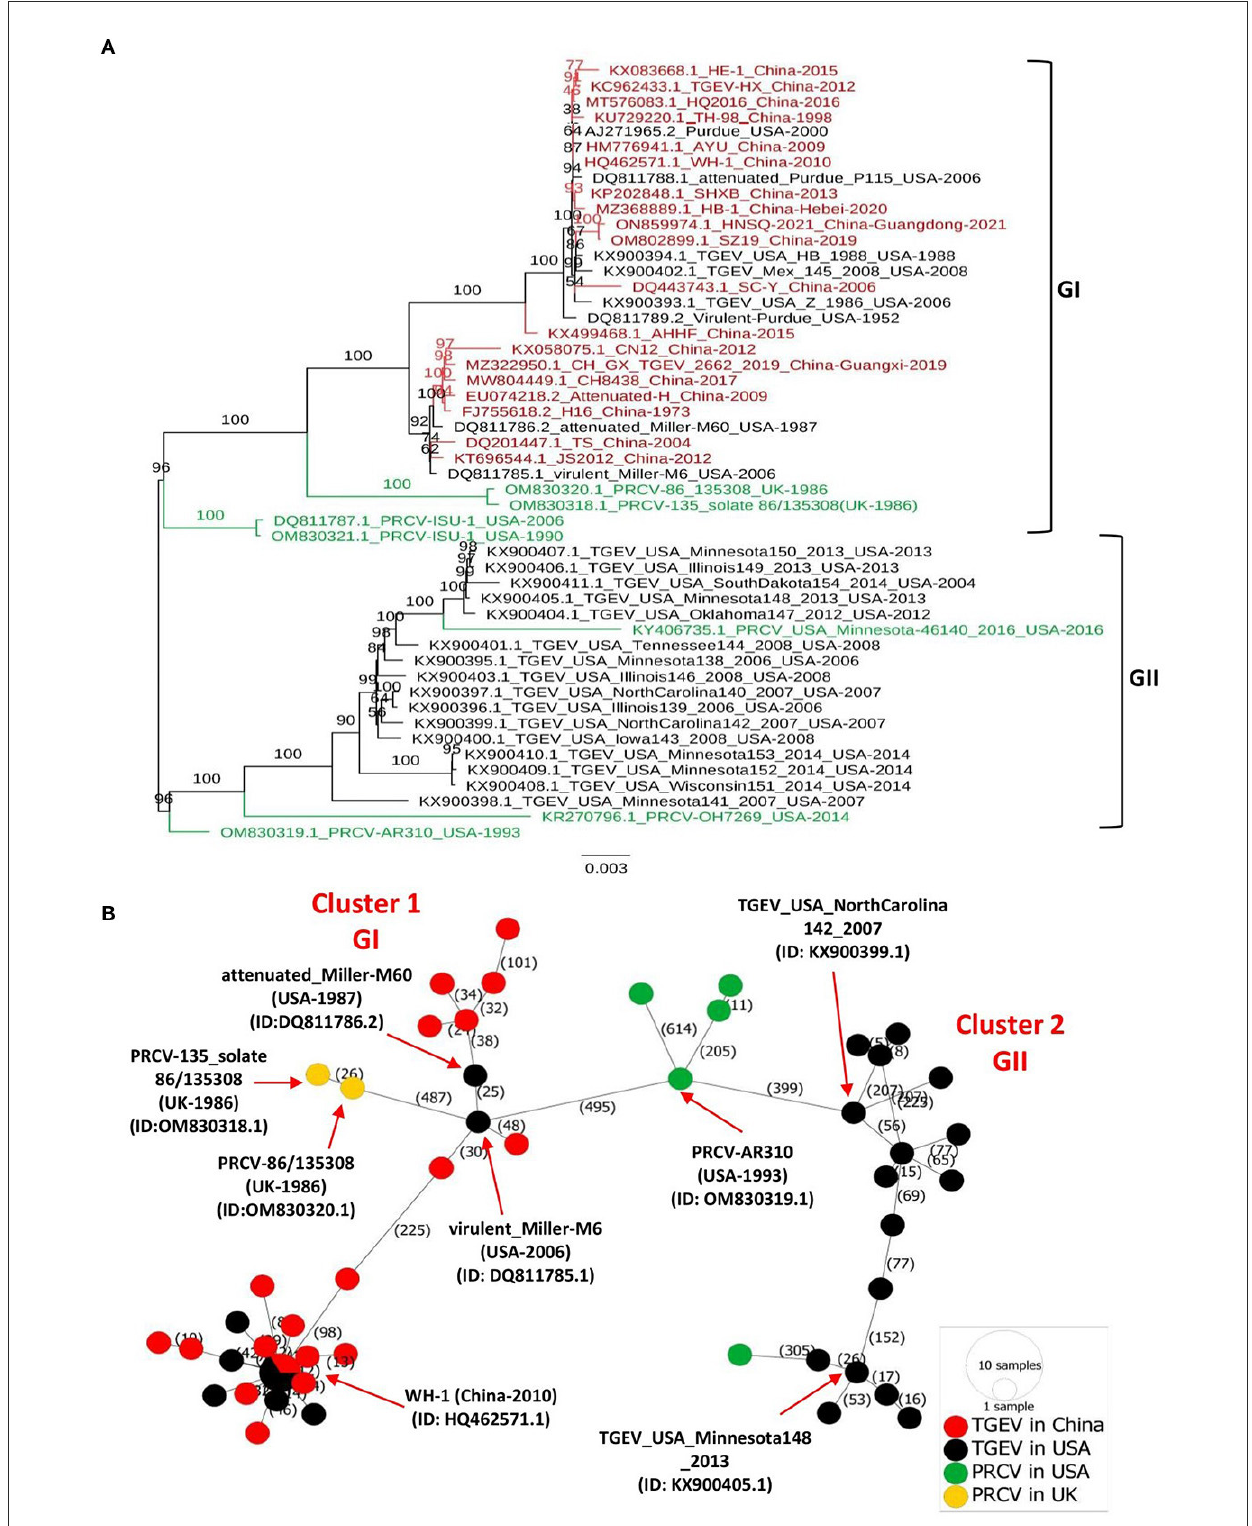
FIGURE1 Phylogenetic tree and phylogeographic network of TGEV and PRCV strains. (A) Complete genome sequence-based ML tree. All complete genome nucleotide sequences were aligned using the MEGA11 software (37) and edited with the BioEdit v7.2.5. The ML phylogenetic trees were inferred using the IQ-TREE multicore version 1.6.12 (28) with 1000 bootstraps and the best-fitting model TIM + F + I + G4. The numbers on each branch are the bootstrap values (%). The scale bar represents a length corresponding to 0.003 nucleotide substitutions per site. Virus strains are formatted as GenBank accession number: virus name (country-year of collection). The red indicates TGEV from China, and the black indicates TGEV from the USA. The green color indicates PRCVs. (B) Phylogeographic network. The complete genome sequences of TGEV and PRCV were used to infer the Minimum Spanning Network (MSN) implemented by PopArt v1.7 (38). The network included 50 TGEV/PRCV strains, where 24 TGEV strains were from the USA, 19 TGEV strains from China, 5 PRCV strains from the USA and 2 PRCV strains from the UK. The mutation numbers are